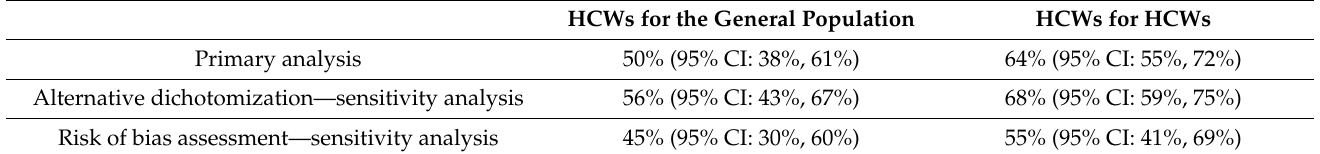
Table 3. Comparison between the results of the primary analysis and the sensitivity analyses.